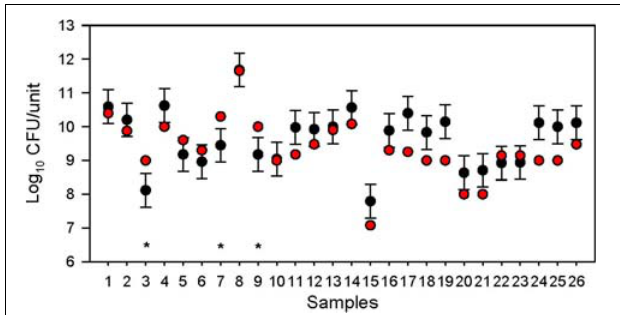
FIGURE 1 | Compliance of 26 dietary supplements with the labelled number of colony-forming units (CFU; bacteria). Black dots, number (CFU/unit of product) determined by plate counting; whiskers, 0.5 log 10 acceptable accuracy; red dots, labelled number of CFU/unit of product; *, non-compliance with the labelled number of